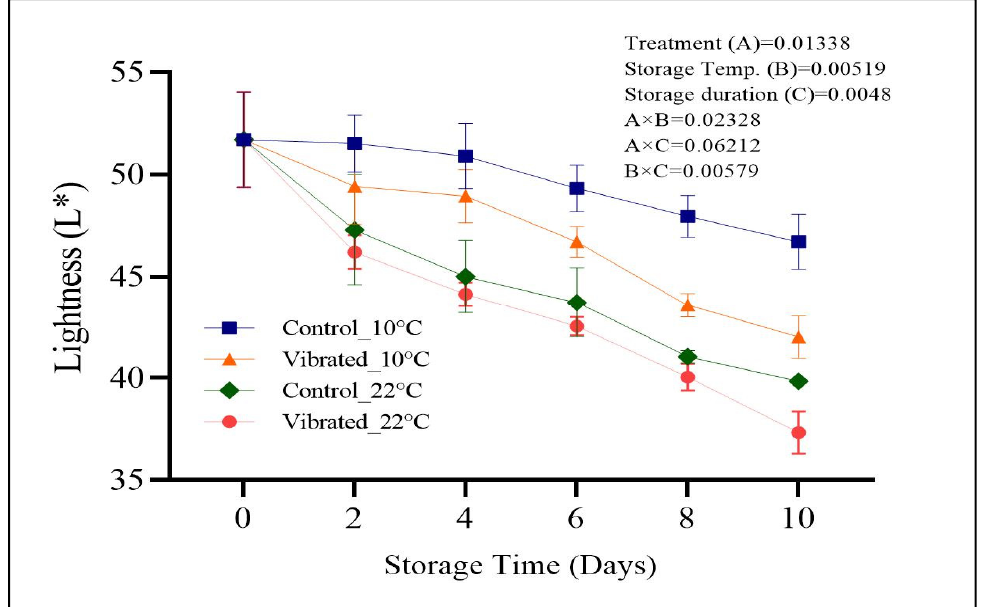
Figure 3. Lightness (L*) value of vibrated and non-vibrated (control) tomatoes stored at (A) 10 °C and (B) 22 °C for 10 days storage. Error bars represent the standard deviation (SD) of the mean values ± S.D of 15 readings per 3 replicates.